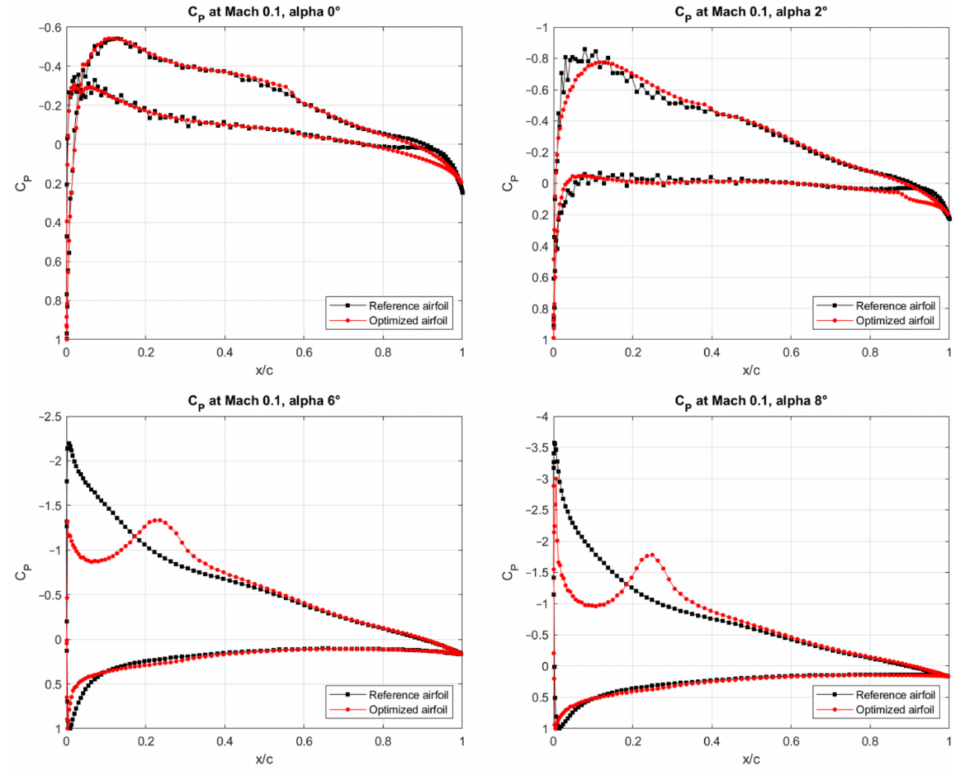
Figure A2. Cp distribution versus the chord obtained for the UAS-S45 optimized airfoil for M = 0.1.